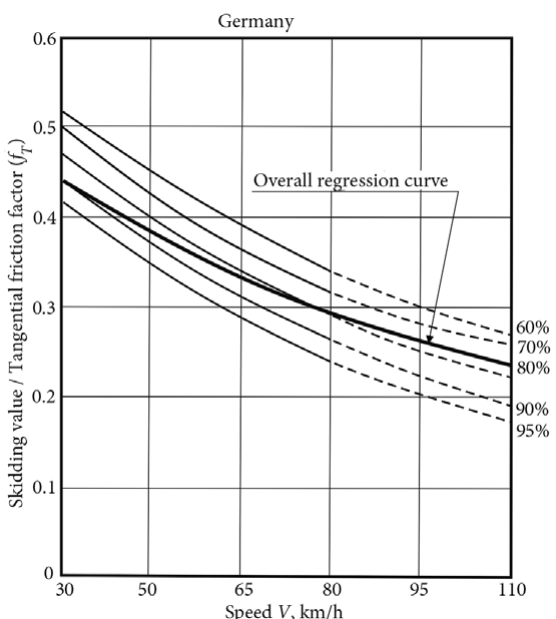
Fig. 4. The overall regression curve compared to tangential friction factors for Germany (Lamm et al.